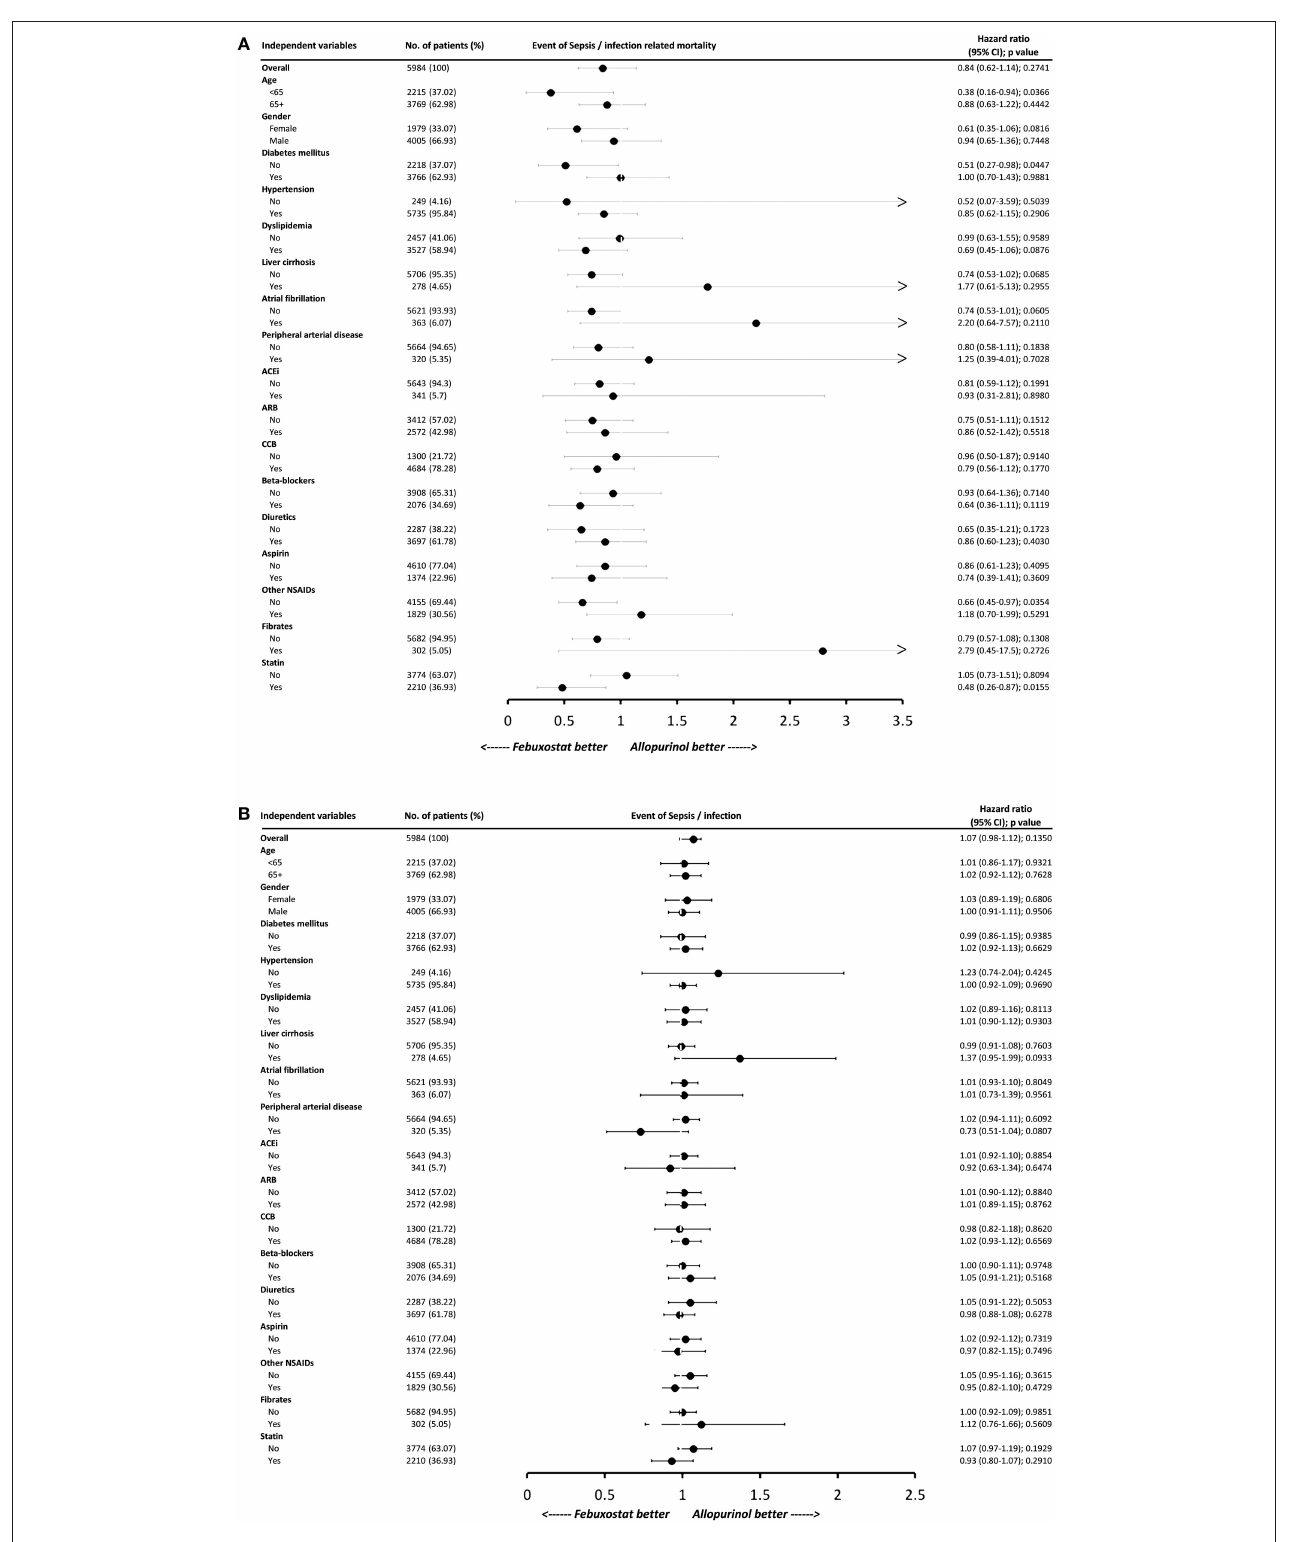
FIGURE 3 | Subgroup analysis of (A) sepsis/infection-related mortality and (B) sepsis/infection. Hazard ratios (HRs) less than one favors febuxostat use. Each variable was adjusted for all other variables listed in Table 1 . HBV indicates hepatitis B virus infection; HCV, hepatitis C virus infection; SLE, systemic lupus erythematosus; ACEi, angiotensin converting enzyme inhibitor; ARB, angiotensin II receptor blocker; CCB, calcium channel blocker; NSAID, non-steroidal anti-inflammatory drug.